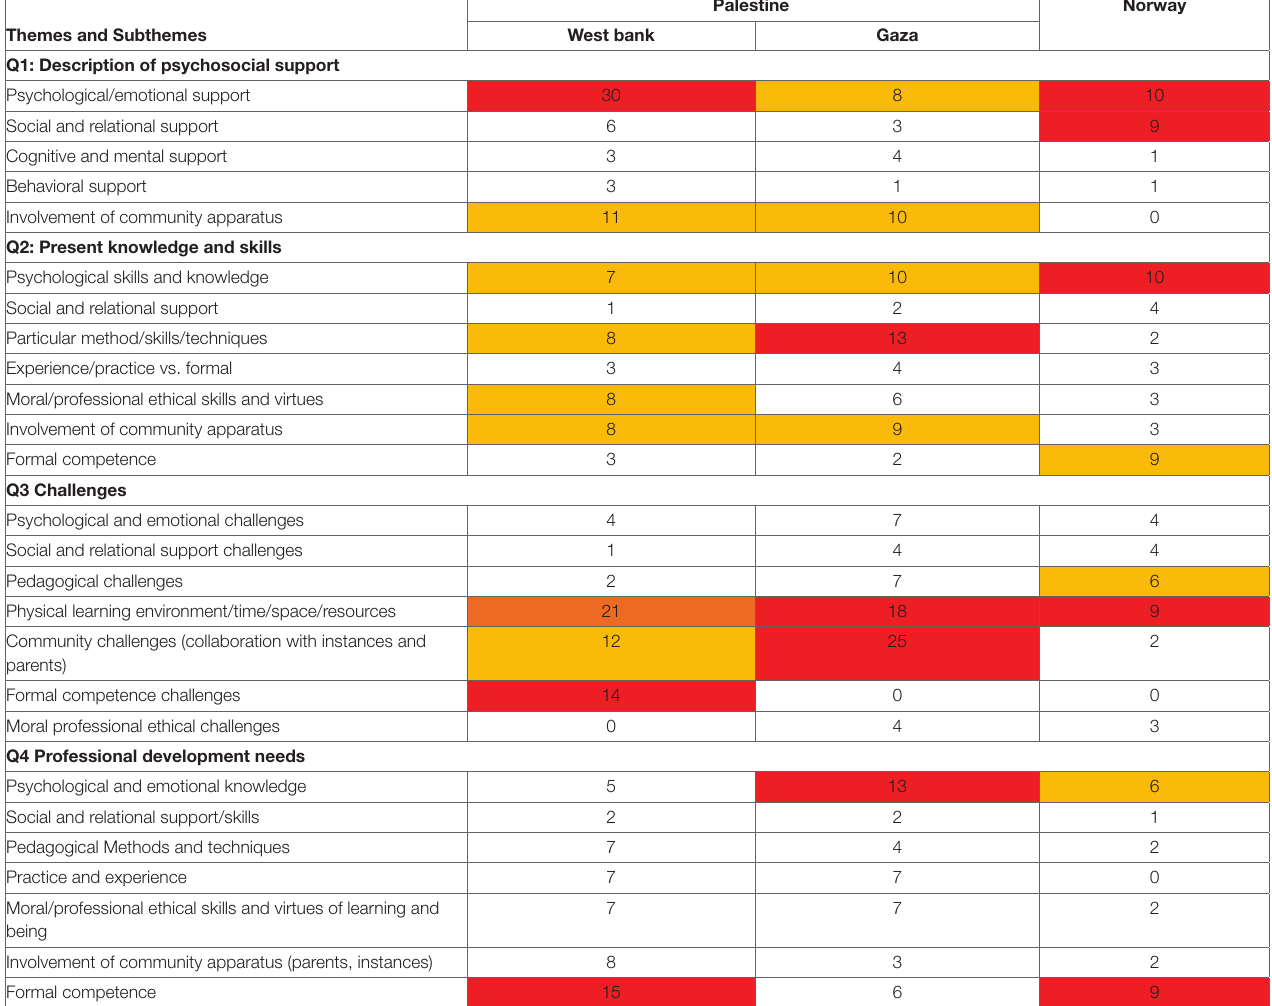
TABLE 1 | Dimensions and emphases of psychosocial support in Palestine and Norway—Overall results of the study.